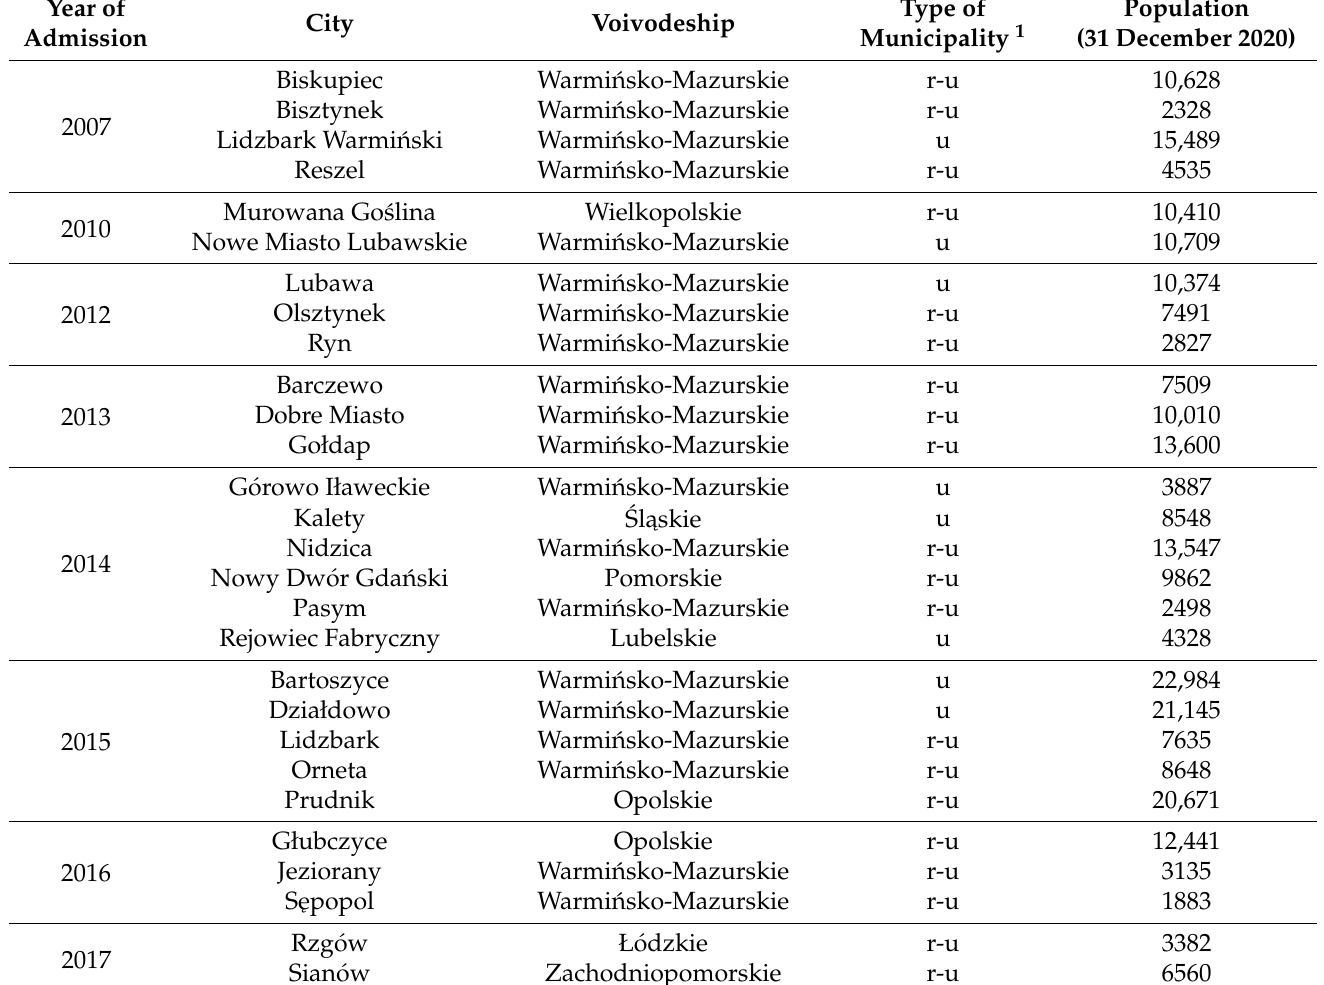
Table 2. Member cities of the Polish National Cittaslow